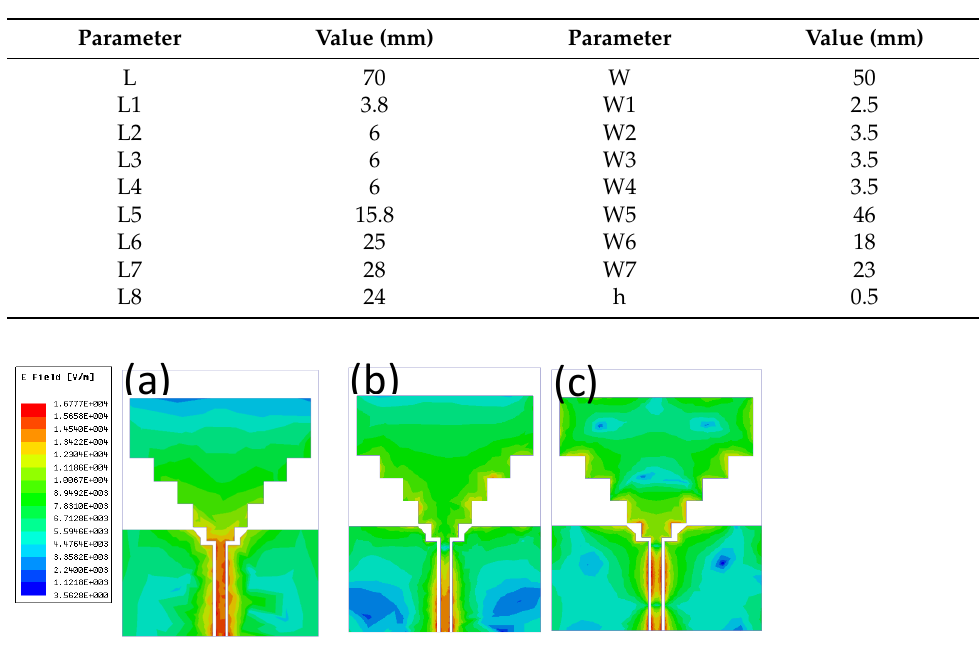
Figure 5. Current distribution diagram ( a ) 2.42 GHz current distribution ( b ) 5.72 GHz current distribution ( c ) 9 GHz current distribution.